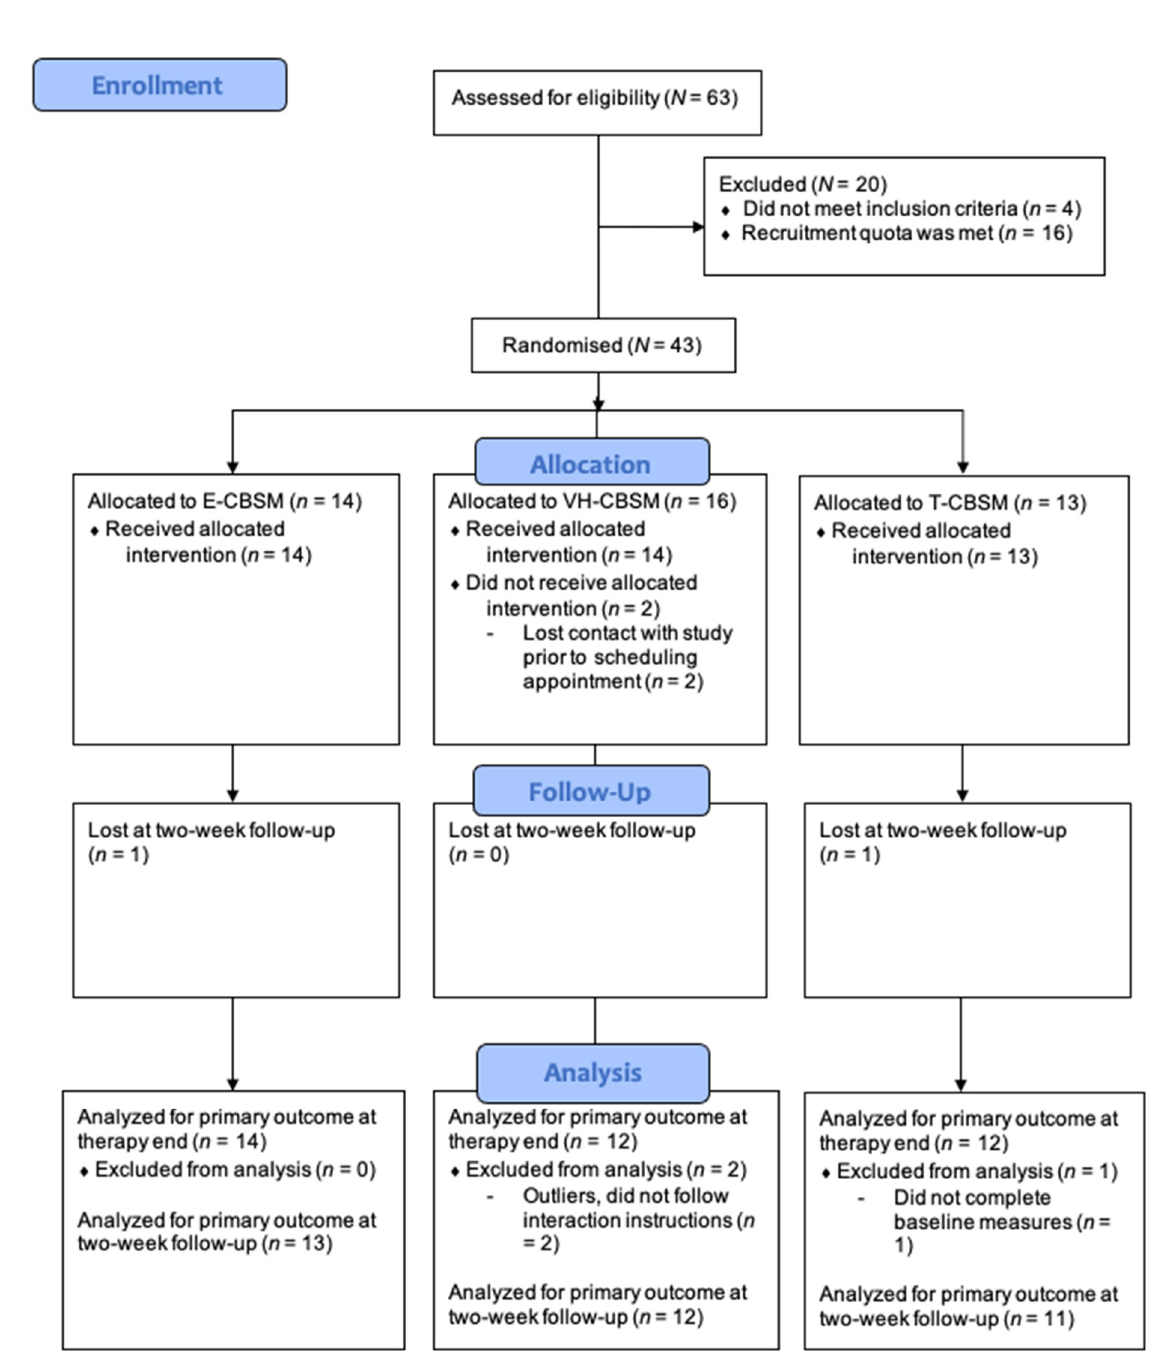
Figure A1. CONSORT Flow Diagram.